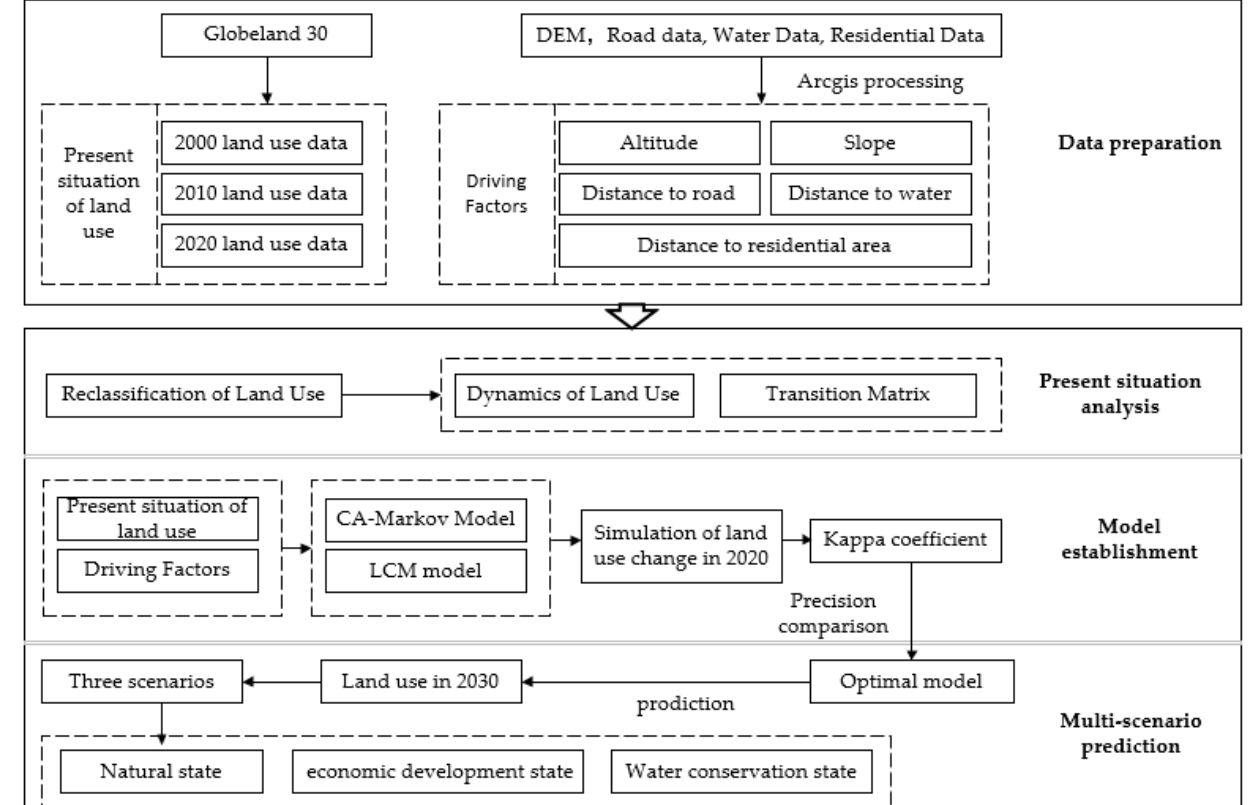
Figure 2. Technical analysis pathway and modeling framework.